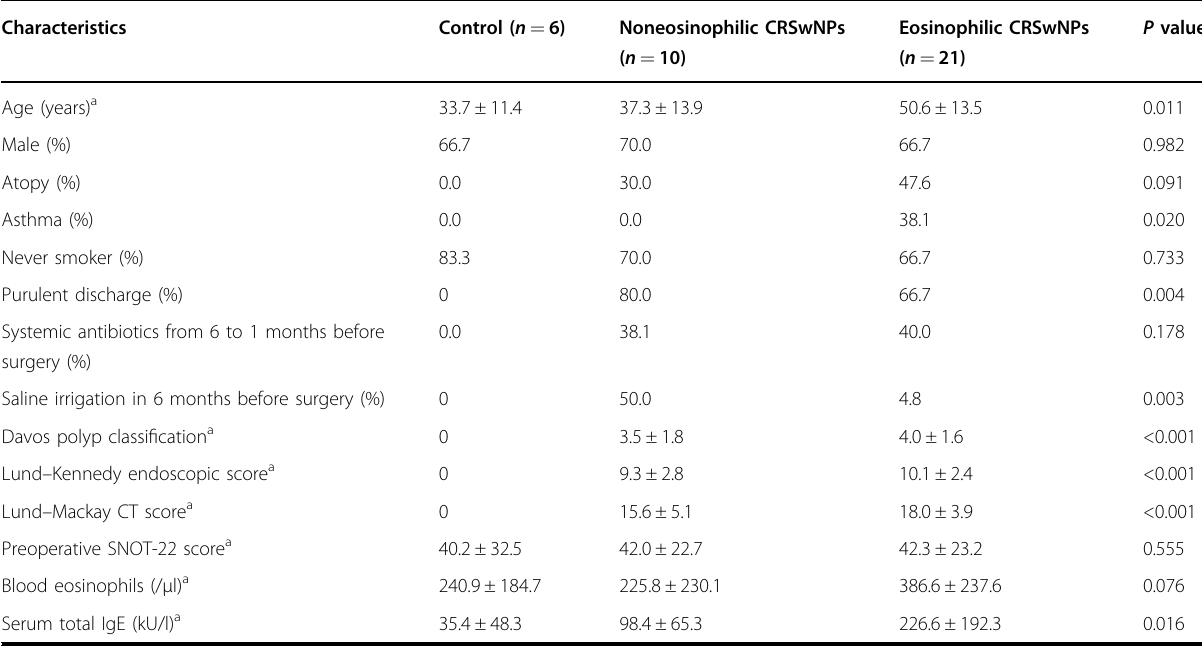
Table 1 Preoperative demographic characteristics of subjects.